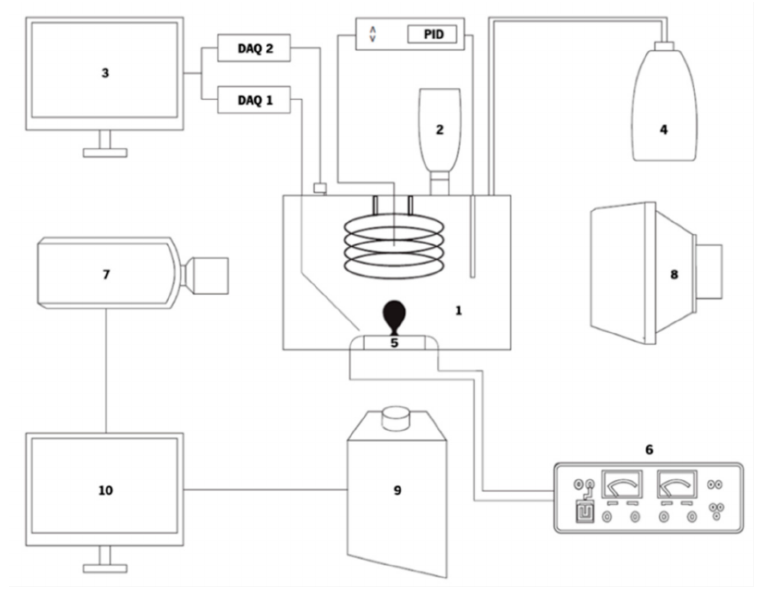
Figure 1. Schematic view of the experimental setup: ( 1 ) boiling chamber, ( 2 ) funnel, ( 3 ) PC, ( 4 ) condensed fluid recipient, ( 5 ) tank base, ( 6 ) DC power supply, ( 7 ) high-speed camera, ( 8 ) LED backlight, ( 9 ) IR camera and ( 10 )